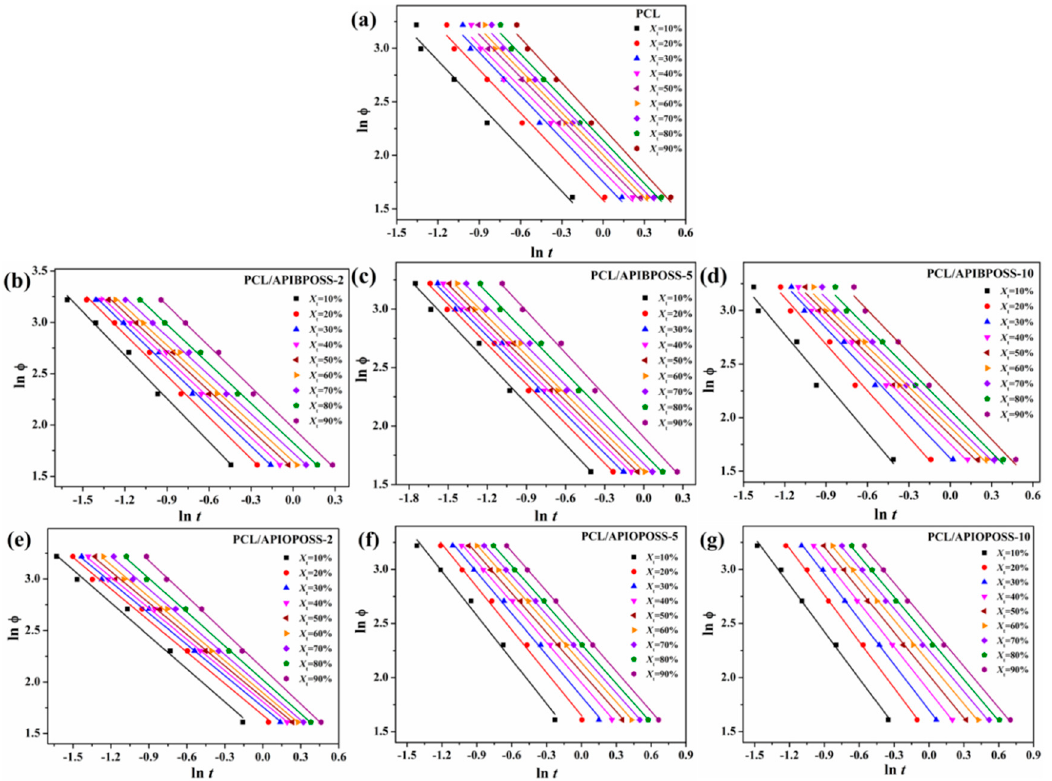
Figure 12. Plots of ln φ versus ln t during the non-isothermal crystallization process of ( a ) PCL, ( b ) PCL / APIBPOSS-2, ( c ) PCL / APIBPOSS-5, ( d ) PCL / APIBPOSS-10, ( e ) PCL / APIOPOSS-2, ( f ) PCL / APIOPOSS-5, and ( g ) PCL / APIOPOSS-10 at di ff erent relative degree of crystallinity. Table 3. The non ‐ isothermal crystallization kinetic parameters based on Mo model for PCL and PCL/POSS nanocomposites.